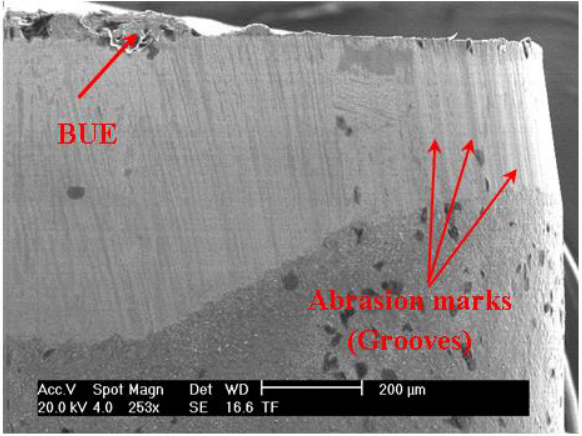
Figure 9. SEM images of the insert utilized in carbon dioxide-assisted cryogenic machining.